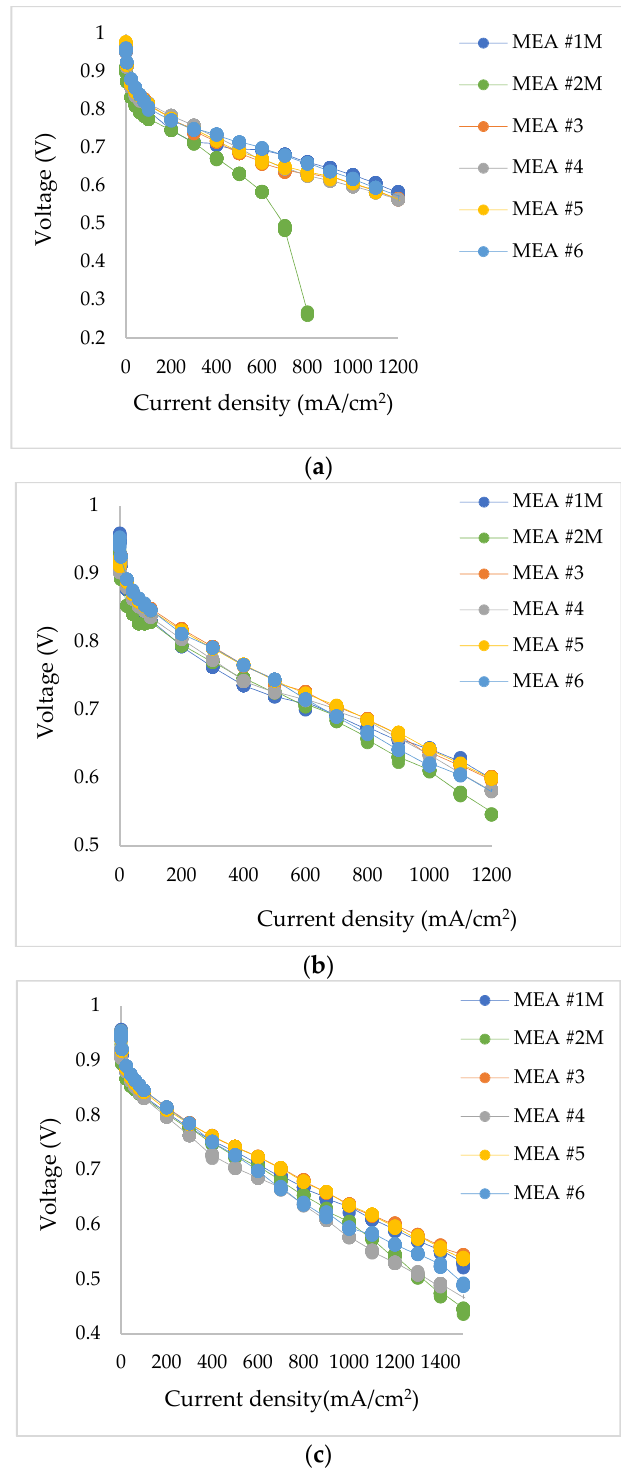
Figure 2. Polarization curves for monolayer (MEA #1M and #2M) and stratified MEAs (MEA #3- #6) obtained for ( a ) 20% RH, ( b ) 60% RH, and ( c ) 100% RH.